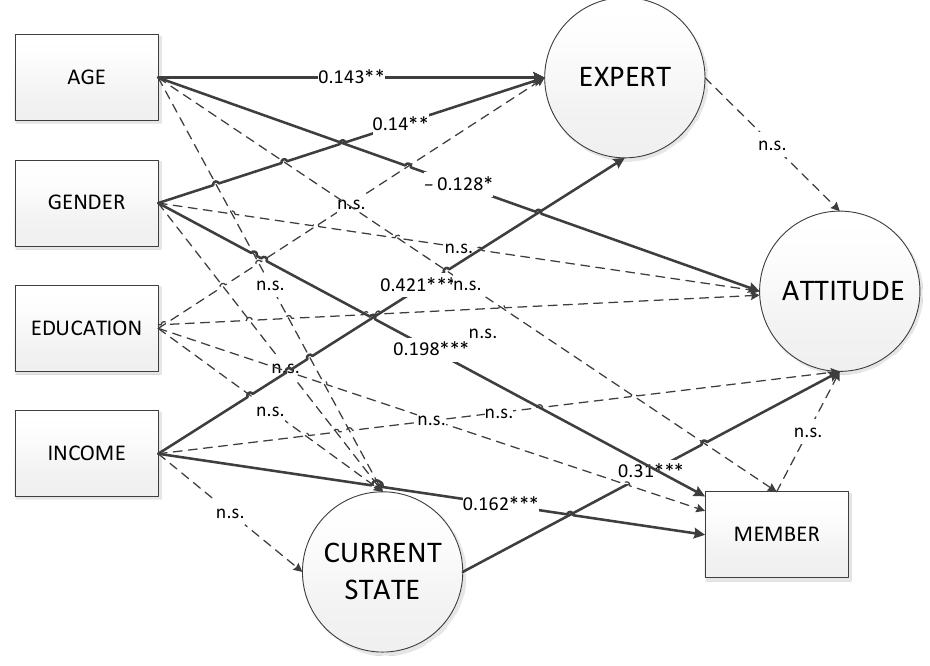
Figure 5. Estimated parameters along with corresponding statistical significance (Model D). * parameter is significant at the 10% significance level. ** parameter is significant at the 5% significance level. *** parameter is significant at the 1% significance level. n.s.: non-significant.